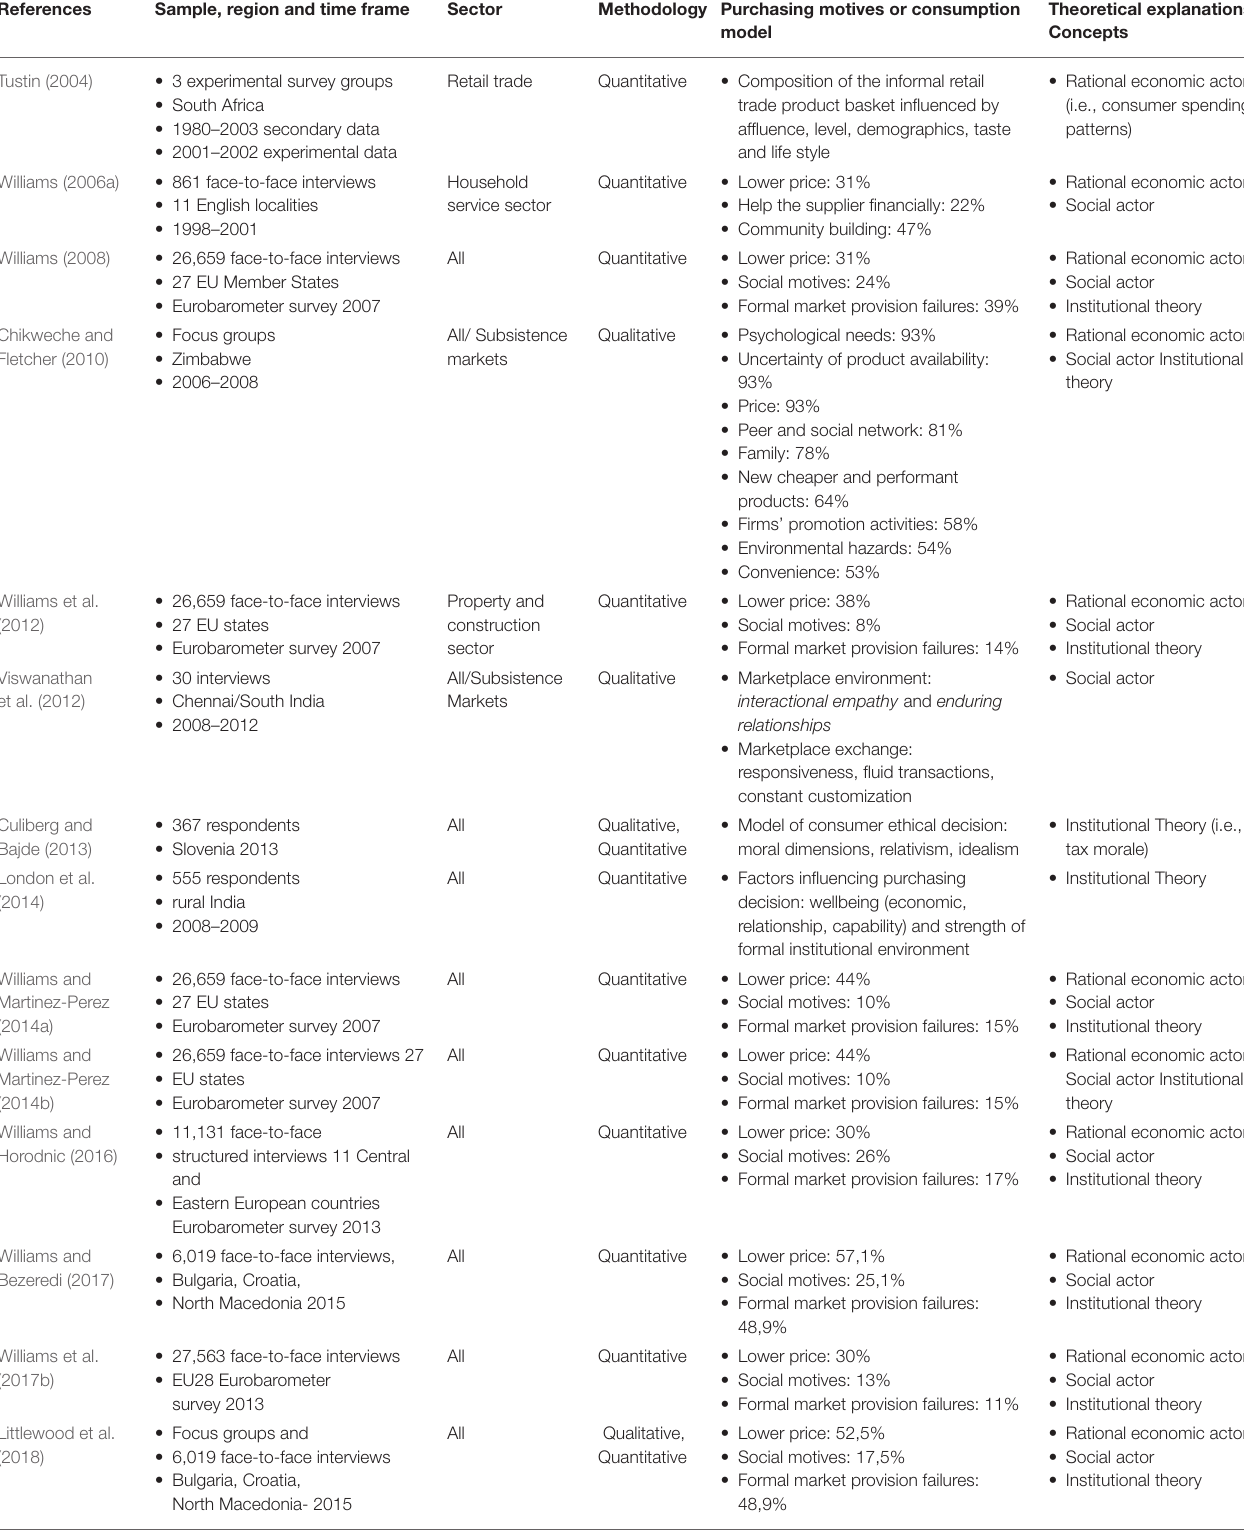
TABLE 2 | Theoretical explanations for the consumer behavior in the informal